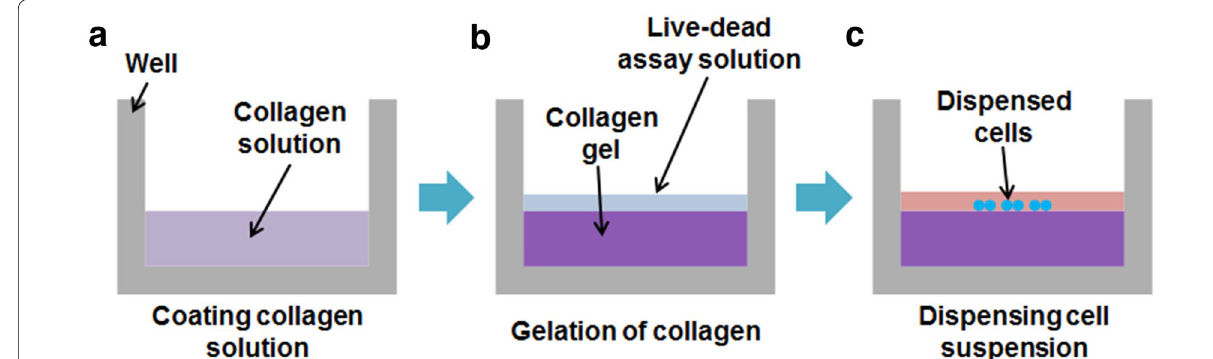
Fig. 2 Schematic views of the cell viability test procedure: a injection of the collagen solution into the well, b thermal gelation of the collagen solu- tion, and c dispensing of a cell-containing droplet